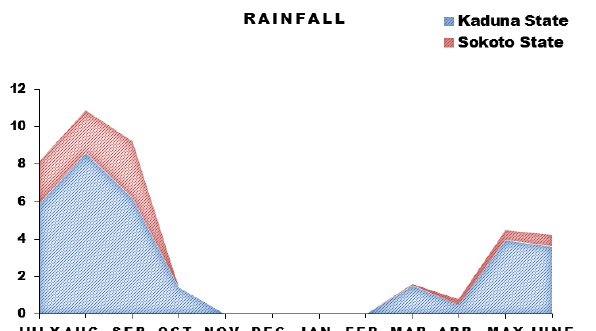
Fig. 7. Mean monthly wind speed values (knot) in Kaduna and Sokoto States